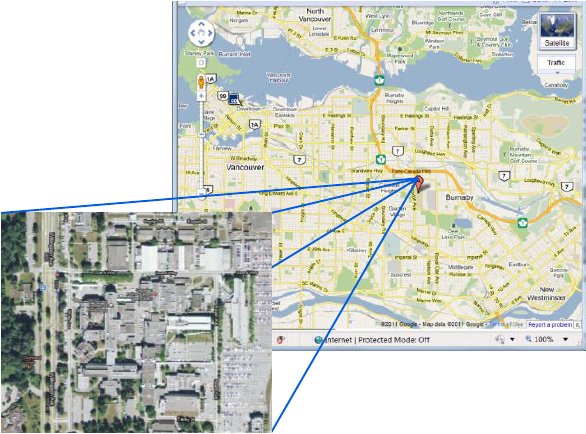
Figure 2: Study Area (British Colombia Institute of Technology, Vancouver)